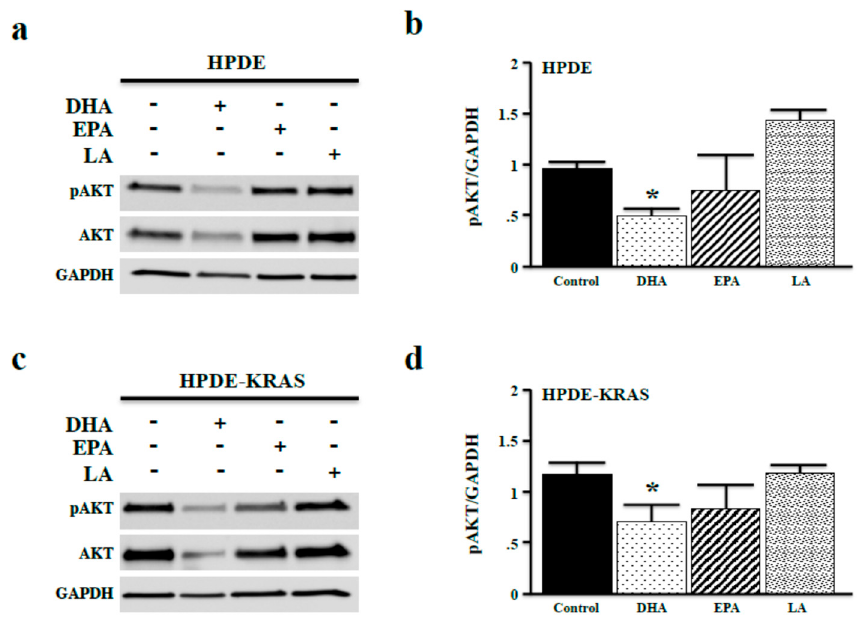
Figure 4. ω 3 fatty acids inhibit AKT phosphorylation in vitro. ( a , b ) HPDE cells were again administered fixed doses of 40 µM of either the ω 3 fatty acids DHA and EPA, or the ω 6 fatty acid LA in vitro. After 48 h, phosphorylated AKT (pAKT) expression was measured by Western blotting and densitometry normalizing expression to GAPDH. ( c , d ) The experiment was repeated in HPDE-KRAS cells. (* p < 0.05).